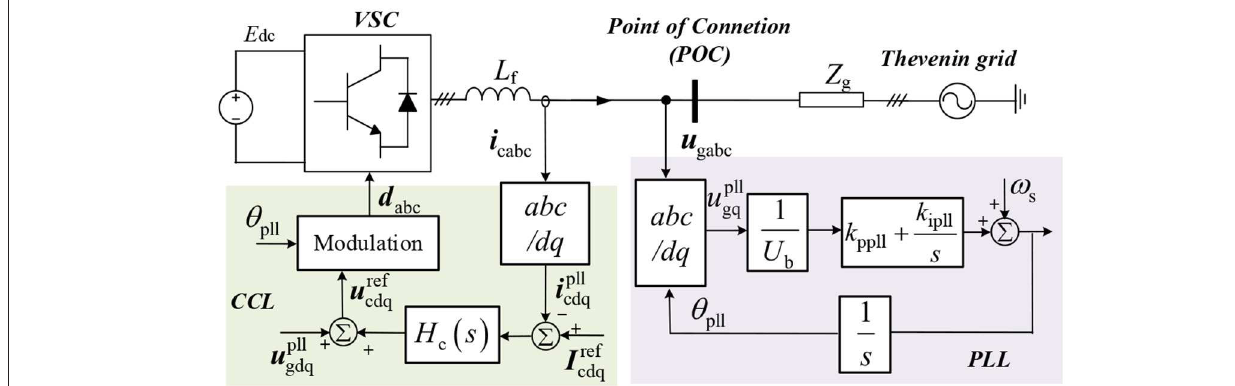
FIGURE 1 | Single line diagram of a typical grid-VSC system.